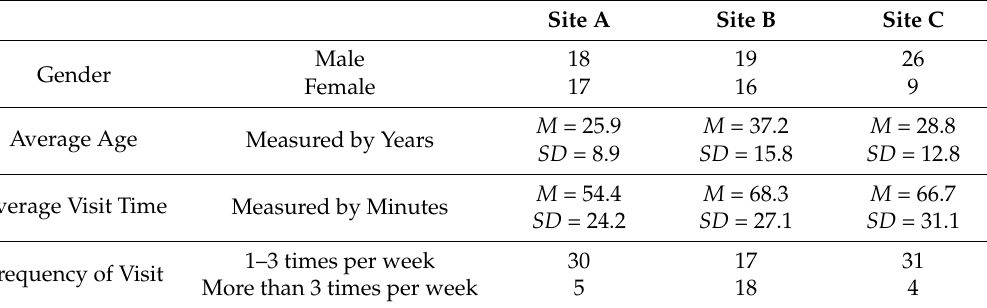
Table 1. Summary of sample demographics ( n =